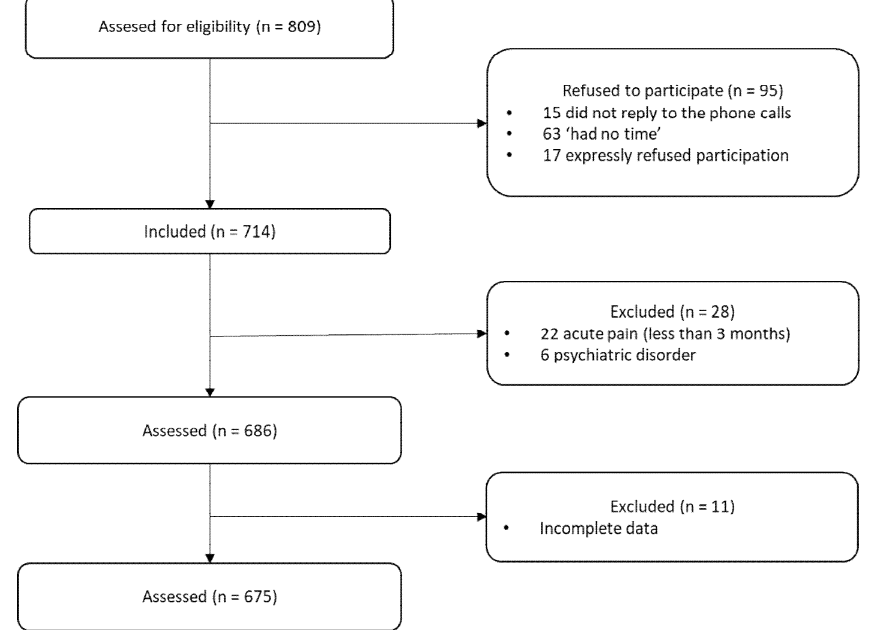
Figure 1. Flow chart of inclusion.